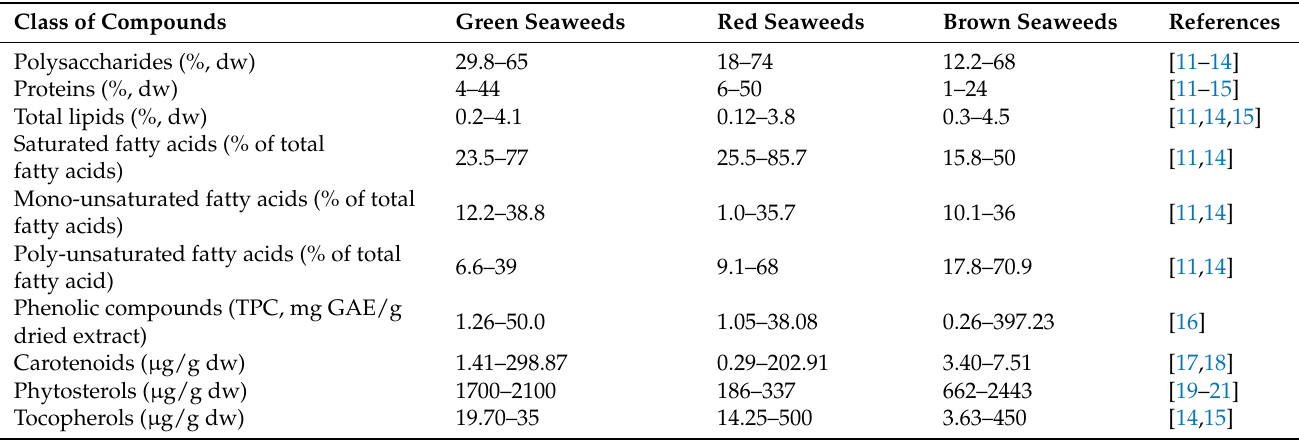
Table 1. Proximate composition and total phenolic, total carotenoid, total tocopherol and total phytosterol contents of